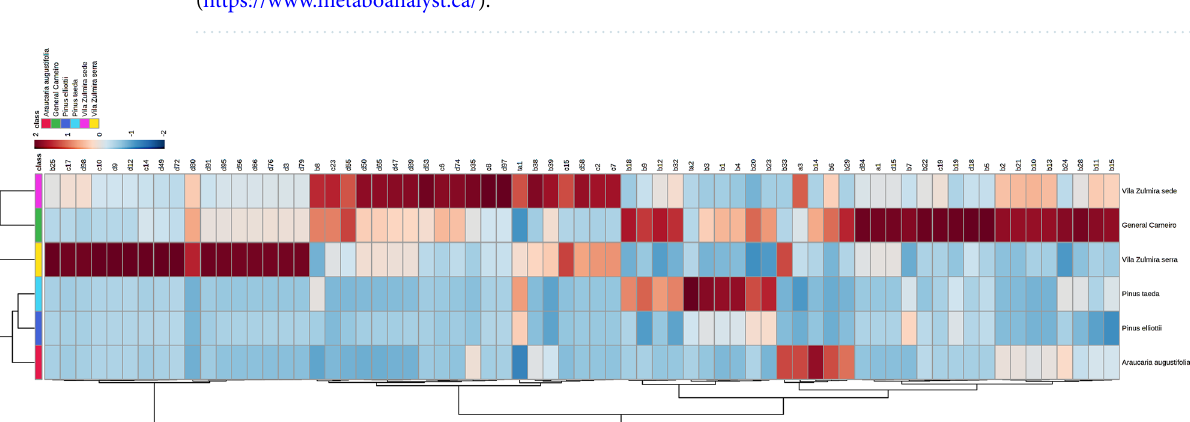
Figure 1. Pairwise score plots between the two principal components for chromatograms obtained by SHS- GCMS from brown propolis and conifer resins from southern Brazil. The explained variances are shown in the corresponding axes and the overlaps of the colored shaded areas indicate similarities among propolis from General Carneiro, ‘Vila Zulmira sede’ and ‘Vila Zulmira serra’ and resins of Araucaria angustifolia , Pinus taeda and Pinus elliotti at a level of confidence of 95%. Figure was generated by the MetaboAnalyst software, v. 5.0 (https:// www. metab oanal yst. ca/).